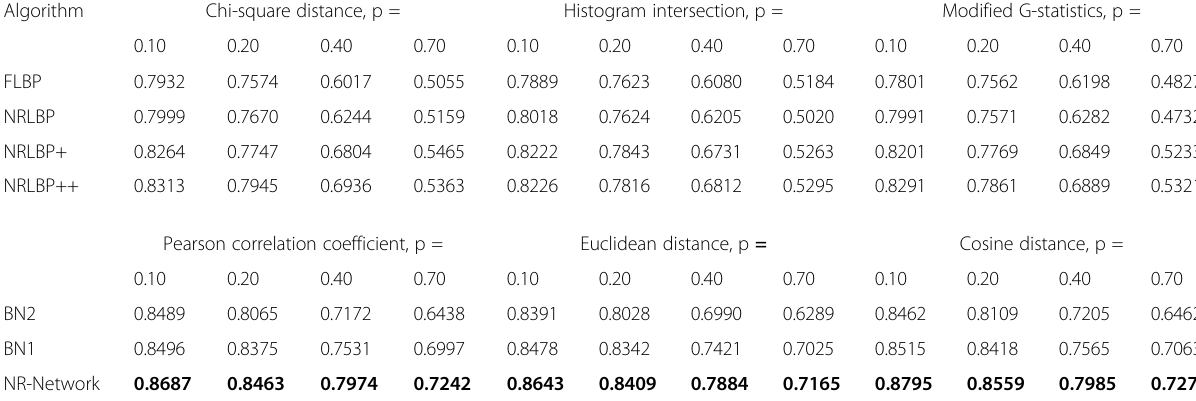
Table 4 The average recognition rates of different methods on the AR database injected with uniform noise